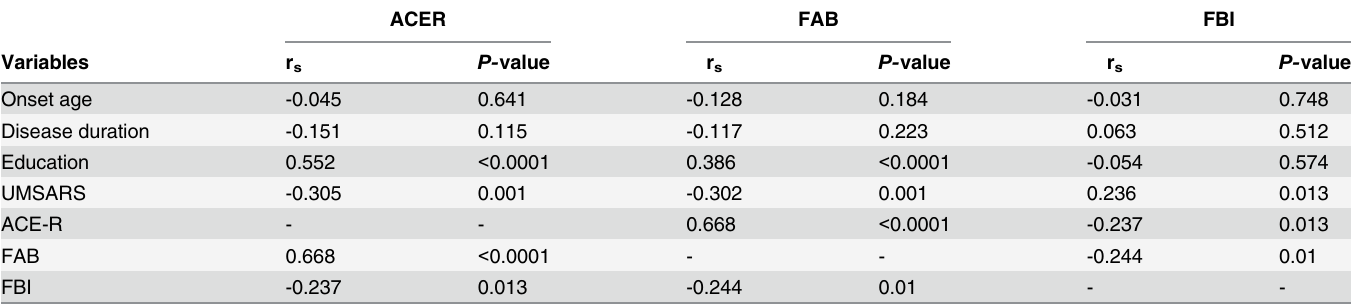
Table 4. Spearman ’ s correlation coefficients between related clinical variables and total ACE-R, FAB, and FBI scores. ACER FAB FBI Variables r s P- value P-